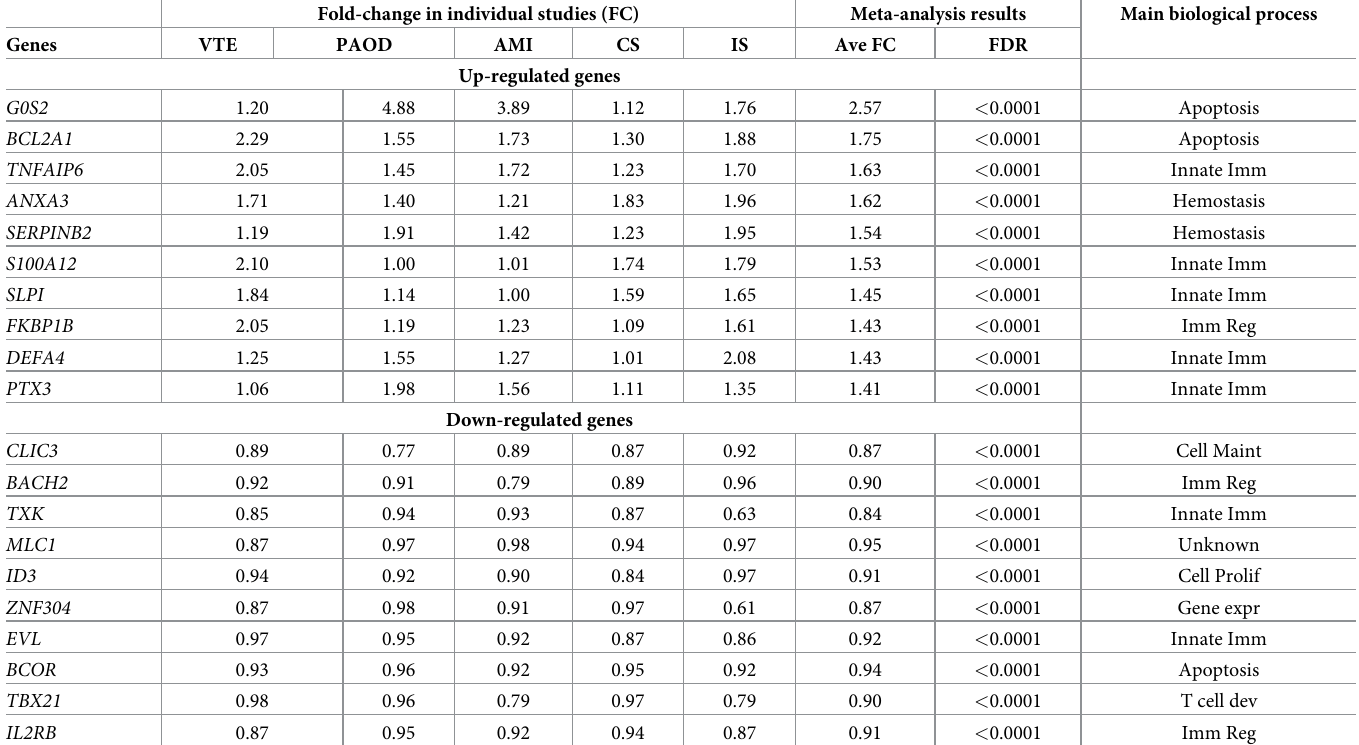
Table 2. Top differentially expressed genes identified in the